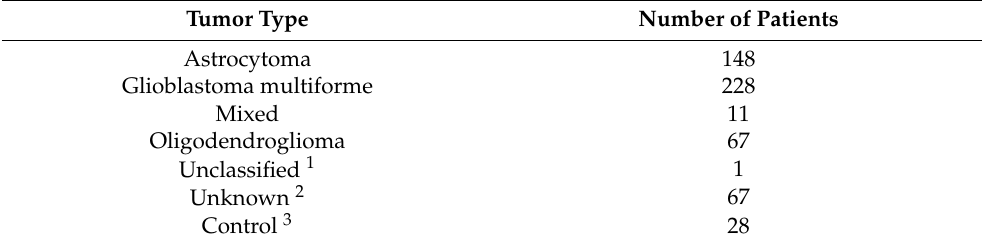
Table 5. Clinical attributes of the GSE108474 metadata from the NCBI GEO